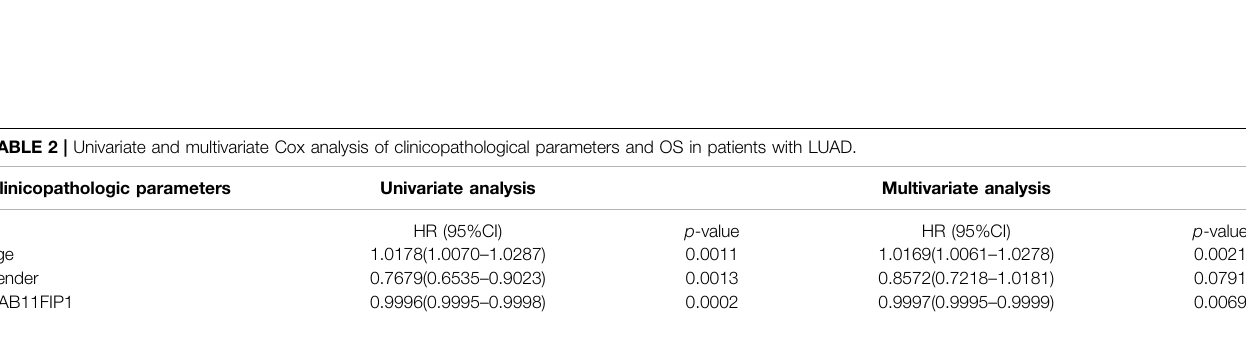
FIGURE 3 | Relationship between RAB11FIP1 and prognosis in LUAD. (A – C) Survival curve of differential RAB11FIP1 expression in LUAD. (D) Multivariate Cox analysis of RAB11FIP1 expression and other clinicopathological variables.